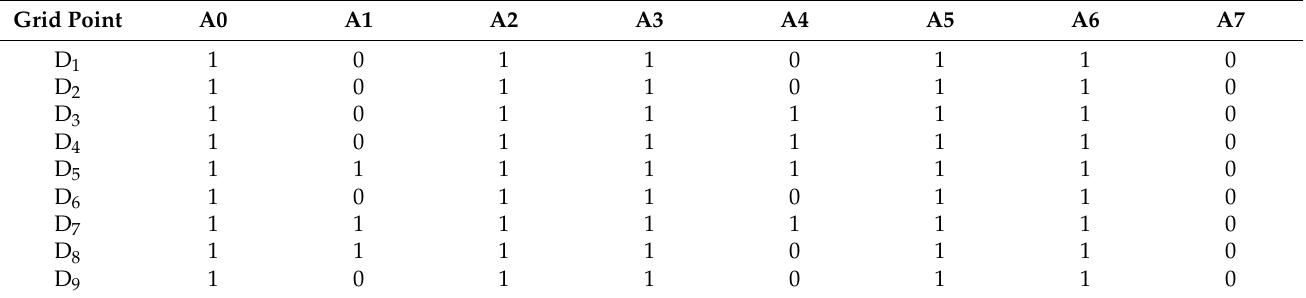
Table 2. Example of values for locating the estimated point proximity area containing nine grid